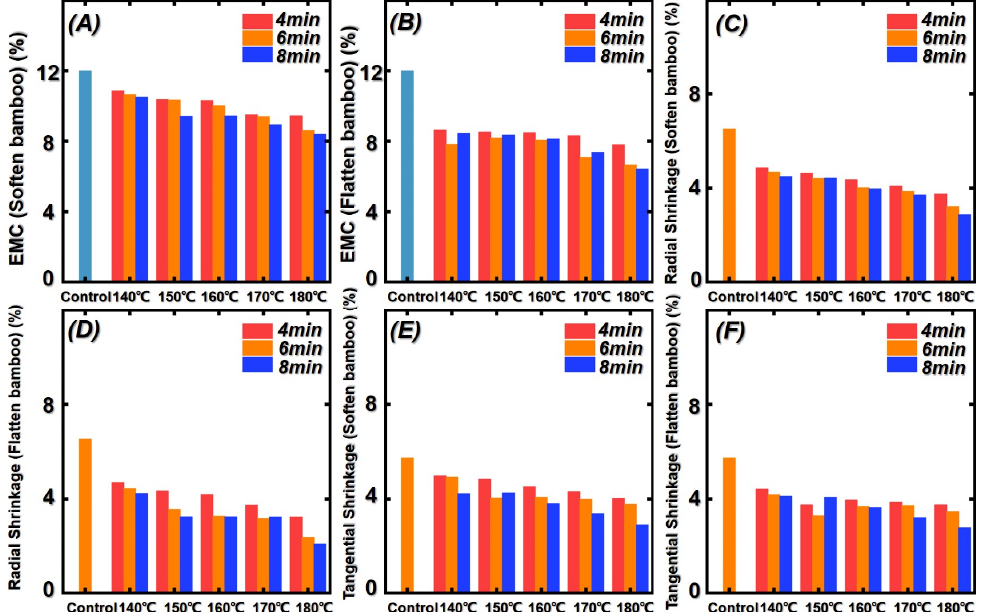
Figure 6. Physical properties of untreated, softened treated, and flattened bamboo samples: ( A ) EMC (softened bamboo); ( B ) EMC (flattened bamboo); ( C ) radial shrinkage ratio (softened bamboo); ( D ) radial shrinkage ratio (flattened bamboo); ( E ) tangential shrinkage ratio (softened bamboo); ( F ) tangential shrinkage ratio (flattened bamboo) .